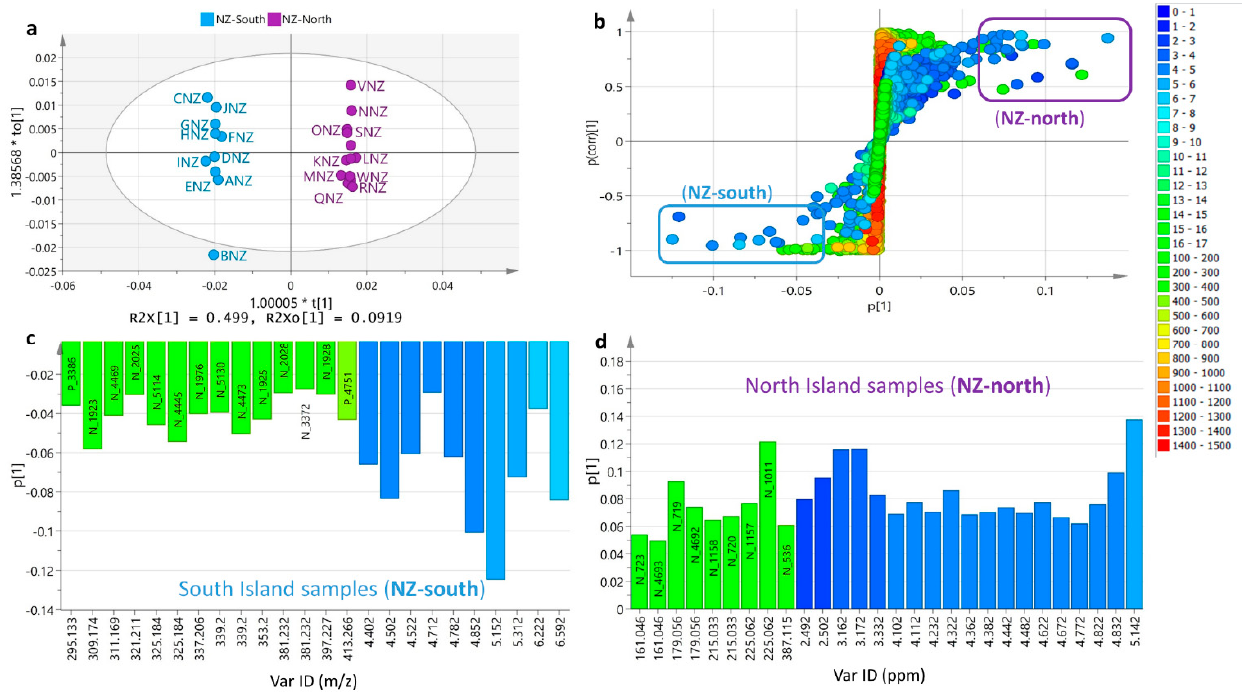
Figure 8. Comparison between honey samples from North and South Islands. ( a ) OPLS-DA scores plot, ( b ) S-loadings plot of mass spectral data of honey extracts, and coefficient bar graphs showing the discriminating metabolites for the North ( c ) and South ( d ) Island samples as exhibited at the “end points” of the S-plot. Permutation test generated a Q 2 Y = − 0.552. Color codes on S-plots are indicated by their chemical shifts in ppm values from 0 to 17 ppm and ion peaks at m/z from 150 to 1500 Da.